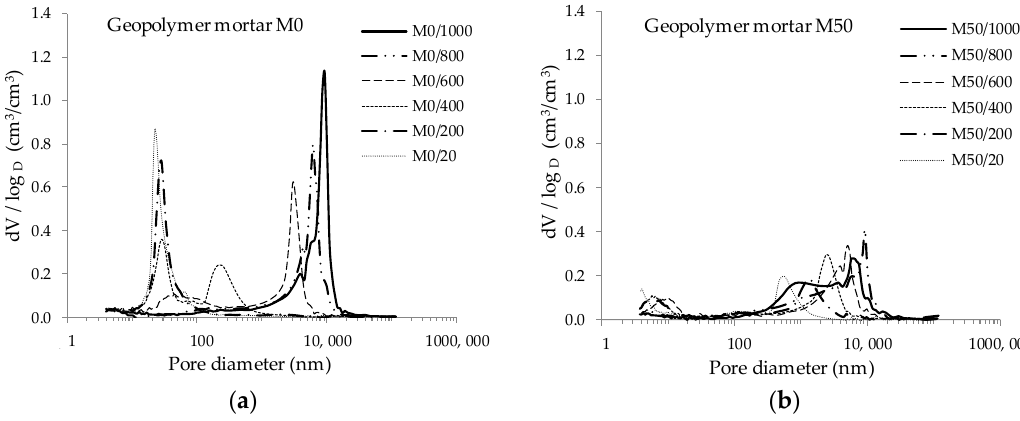
Figure 3. Pore distribution: ( a ) mortars based on FA only; ( b ) mortar with GGBFS addition.